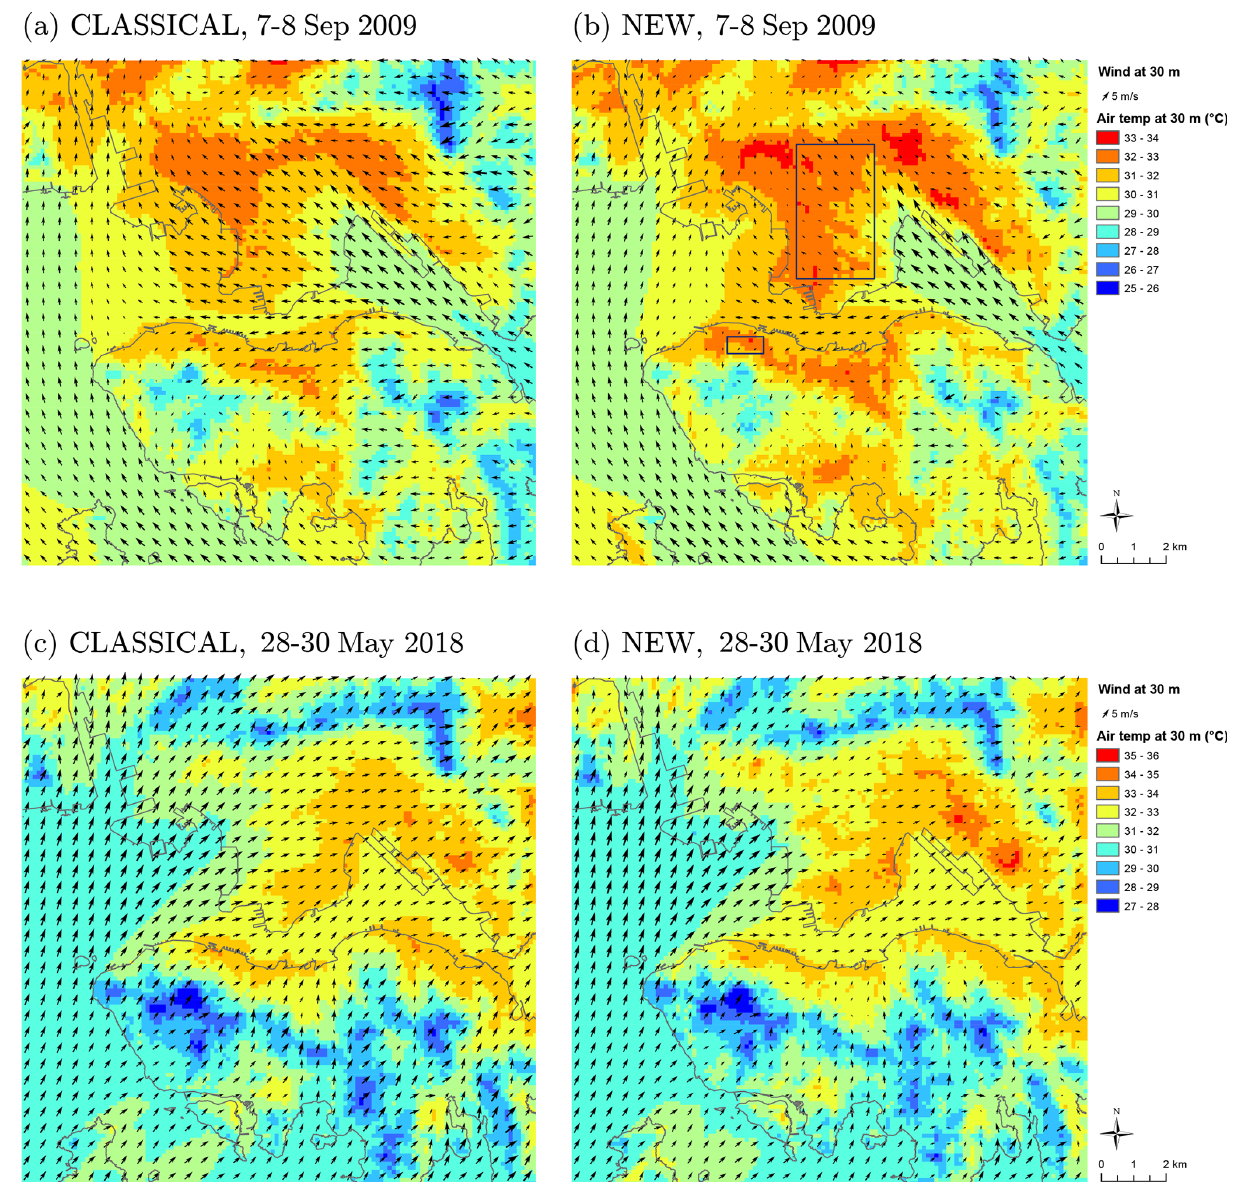
Figure 10. Wind field and air temperature at 30ma.g.l. in the daytime (11:00–16:00HKT) for the CLASSICAL and NEW coupling ap- proaches and two selected time periods during HW2018 and HW2009.